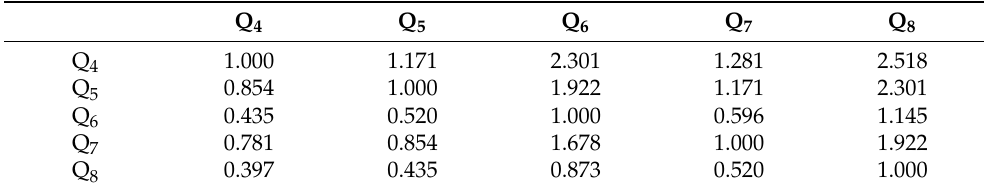
Table 9. Relative reciprocal weights for compared alternatives.